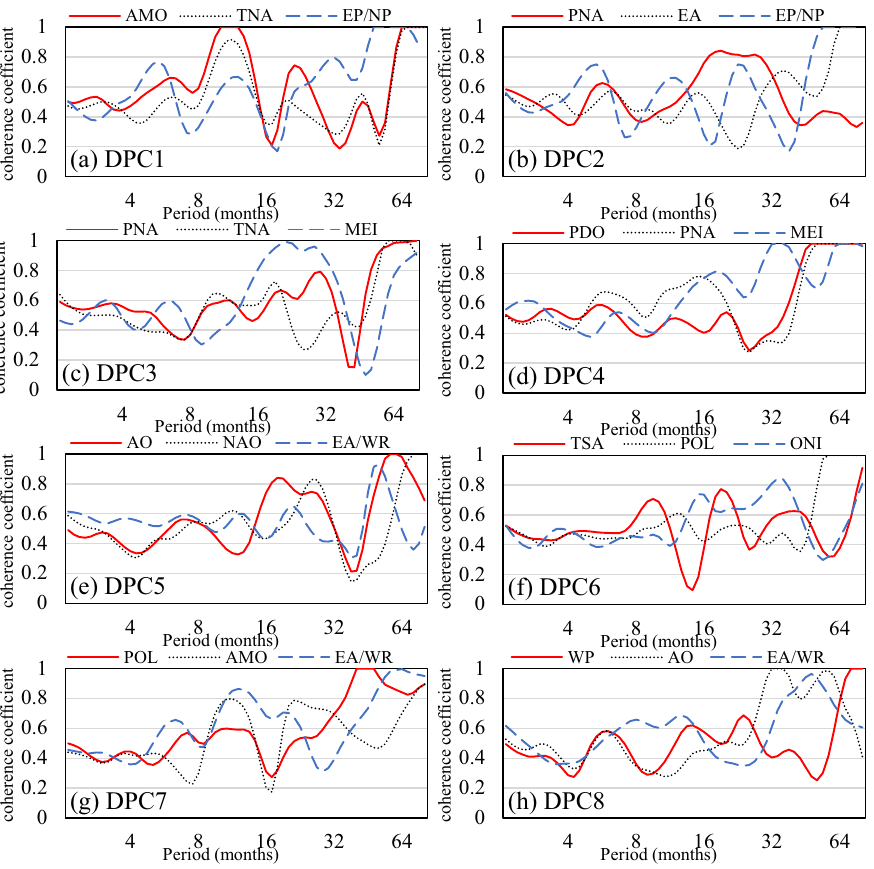
Figure 8. The global coherence coefficient between global climatic drivers and the temporal patterns of DPC1–8. The data used in the calculation comes from Fire CCI v5.1 dataset (https:// geogra. uah. es/ fire_ cci/ firec ci51. php) and NOAA (https:// psl. noaa. gov/ data/ clima teind ices/